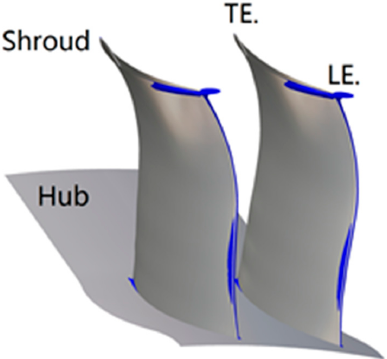
Figure 13. Iso ‐ surface of the axial velocity ( − 1 m/s) for the bowed stator 5 (near the stall points). Figure 13. Iso-surface of the axial velocity ( ´ 1 m/s) for the bowed stator 5 (near the stall points).